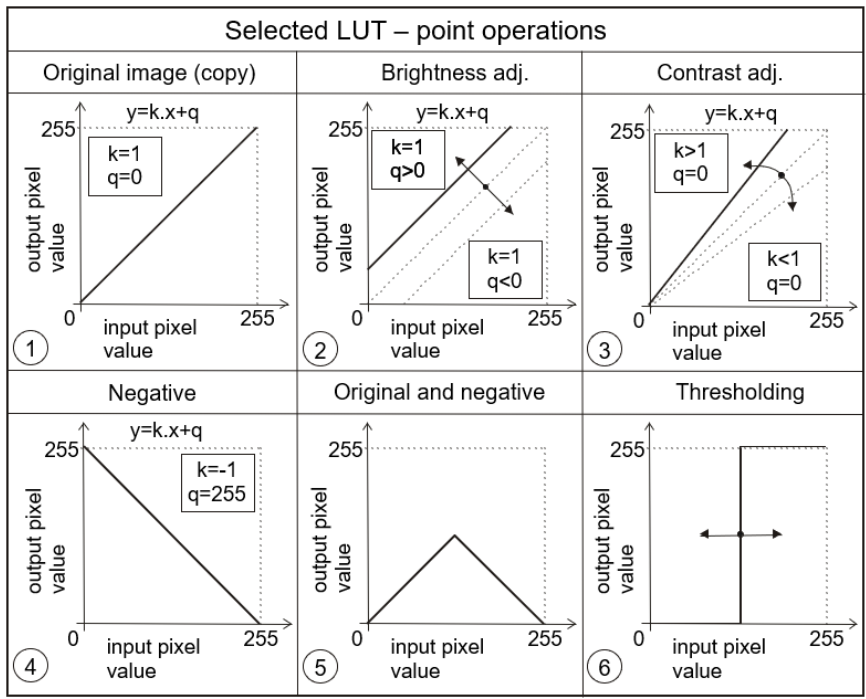
Figure 4. Examples of different point operators (functions) being very often used.